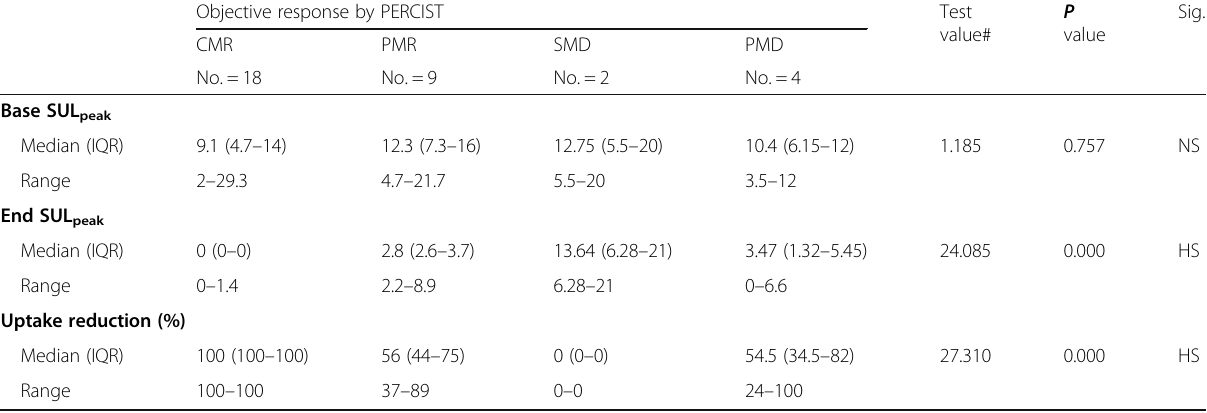
Table 6 Correlation between tumor SUL peak and PET-based therapeutic response in the study population Objective response by PERCIST